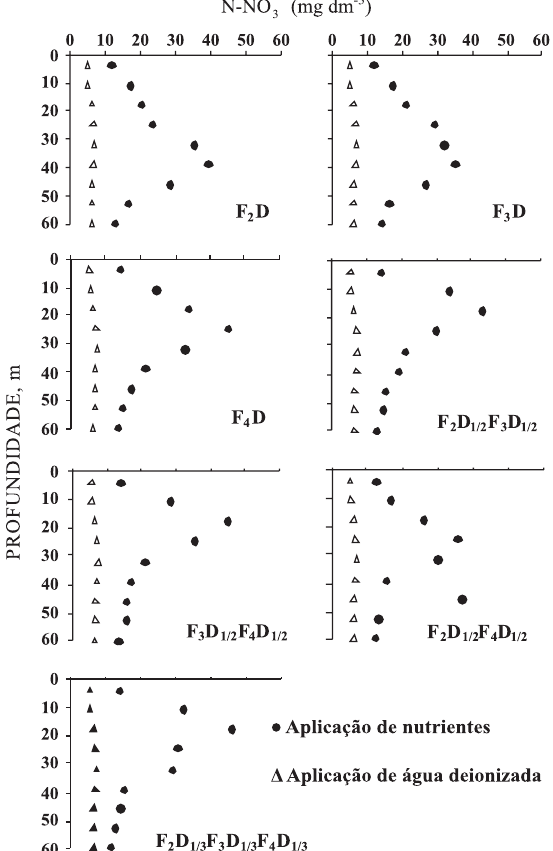
Figura 1. Teores de nitrato ao longo de colunas com amostras do LVAd2, considerando a fração da lâmina de irrigação (F) em que o nutriente foi aplicado em dose integral (D) ou fracionado em duas (D ) ou em três vezes (D 1/2 1/3